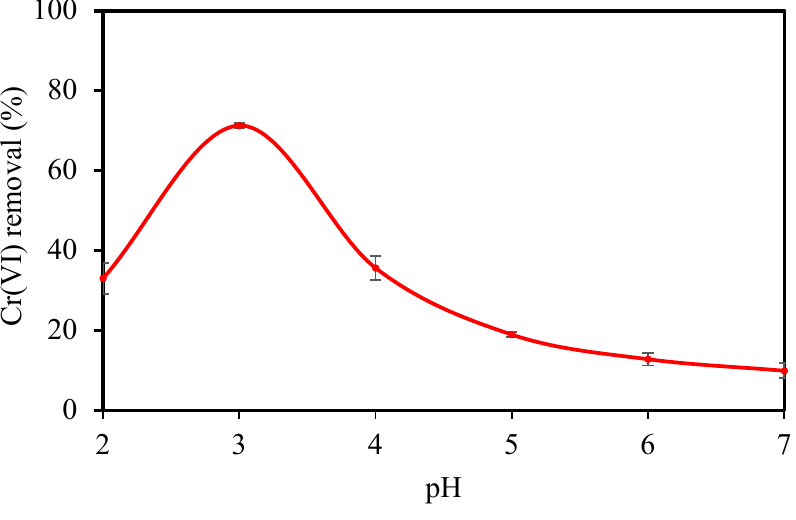
Figure 11. Effect of feed pH on the Cr(VI) removal of CCCM.